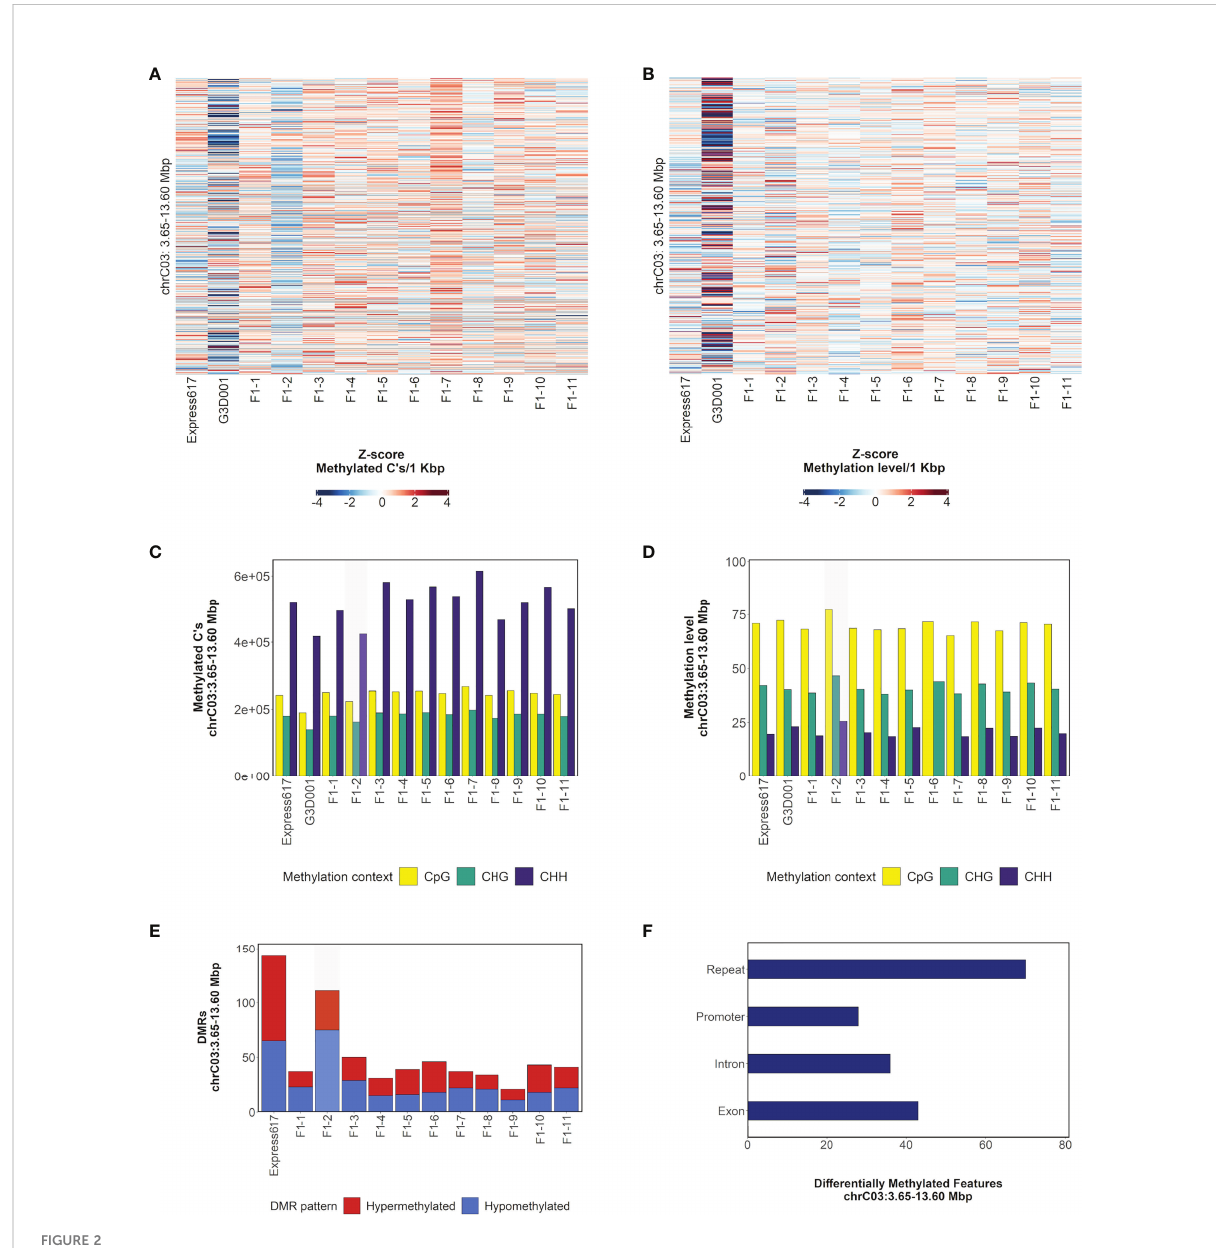
FIGURE 2 Methylation patterns in chromosome C03: 3.65 – 13.60 Mbp in F1 sister plants and parents. (A) , Distribution of methylated cytosines in CpG methylation context per 1 kbp bins. Bins are sorted from bottom to top of heatmap by ascending genomic position. (B) , Distribution of methylation level in CpG methylation context per 1 kbp bins. Bins are sorted from bottom to top of heatmap by ascending genomic position. (C) , Count of methylated cytosines per methylation context. (D) , Methylation level per methylation context. (E) , Count of hypo- and hypermethylated DMRs in comparison to G3D001. (F) , Distribution of DMRs across introns, exons, repeats and promoters (1 kbp upstream from gene start). The number in the F1 samples indicates their biological replicate name. A genotype carrying a spontaneous segmental deletion on chromosome C03 is highlighted in